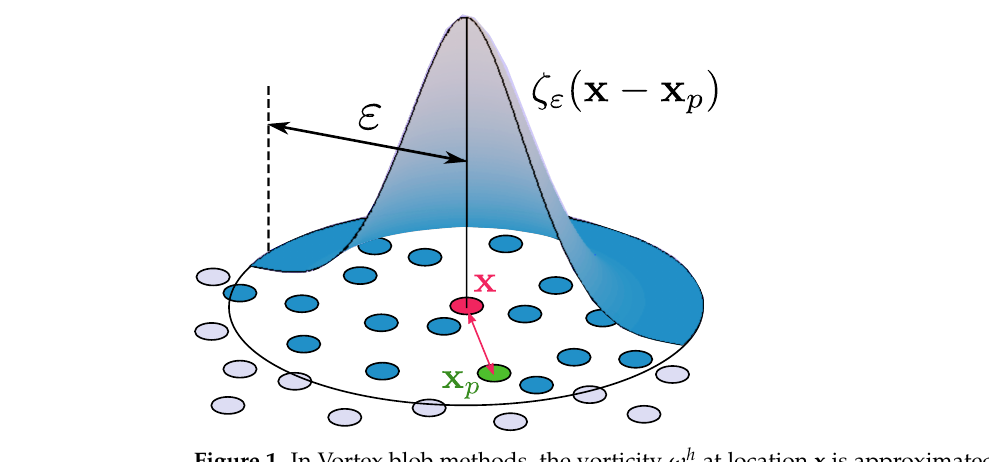
Figure 1. In Vortex blob methods, the vorticity ω h at location x is approximated as the sum of the local circulations α h p carried by the neighboring particles of volume v p and located in the support of the ζ ε mollified